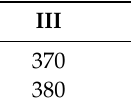
Table 3. Exhaust and fresh air